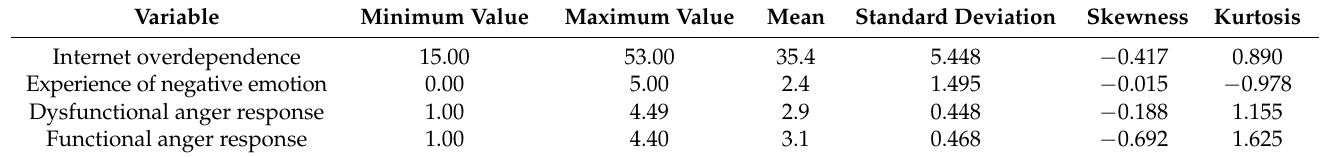
Table 2. Descriptive statistics for major variables.